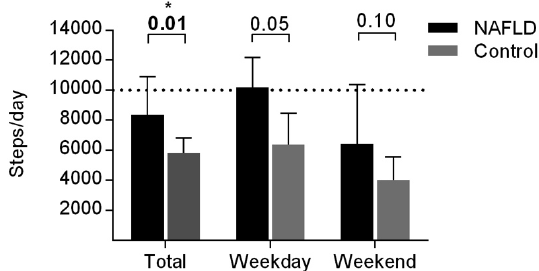
Figure 4. Average steps recorded using pedometer during participant completed 7 ‐ day physical activity diary. Data are unadjusted and expressed as median + 3rd quartile. p ‐ values from Mann ‐ Whitney Test. p < 0.05 is considered statistically significant. Dashed line represents 10,000 steps; minimum number of steps required by adolescence to meet 60 min/day moderate ‐ to ‐ vigorous physical activity recommendation [32].